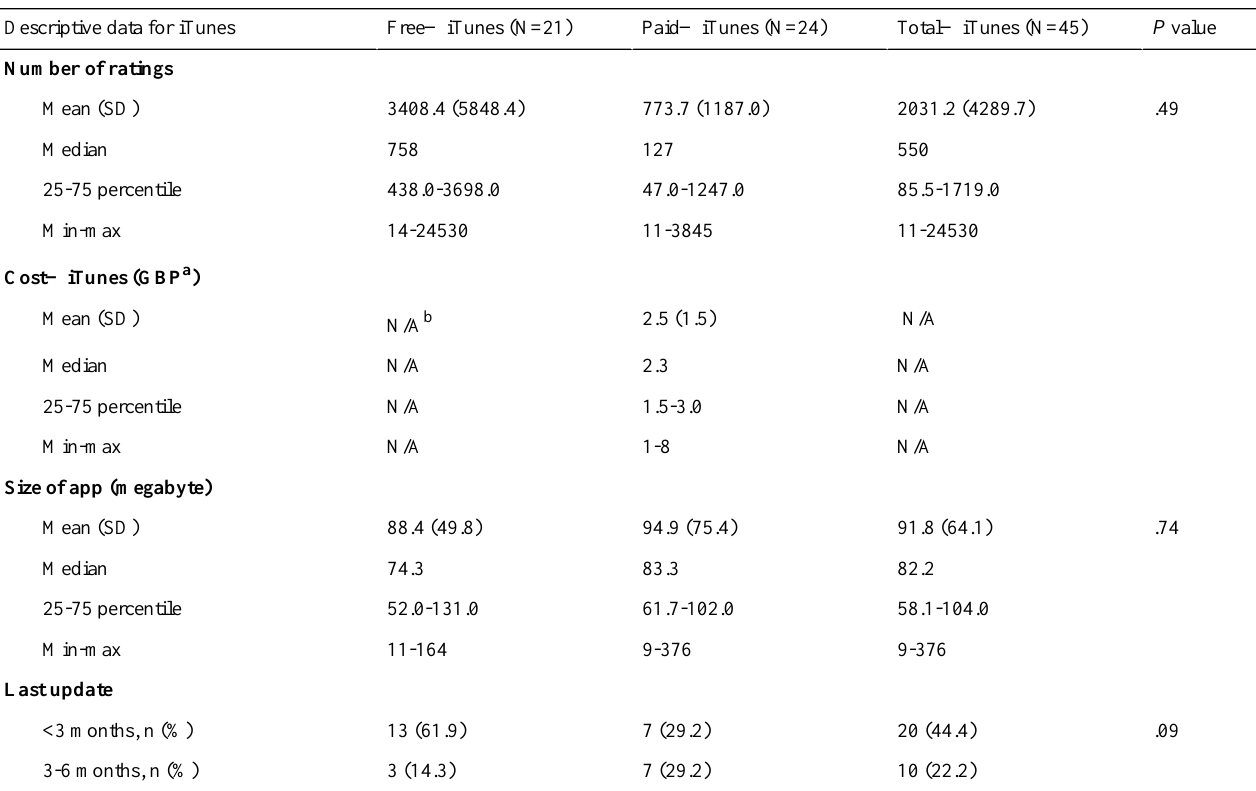
Table 2. Descriptive data for iTunes